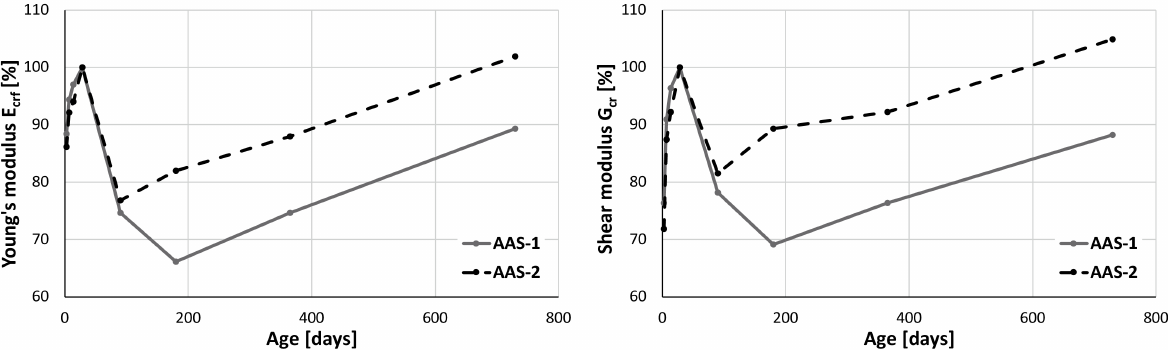
, the 28-day value represents cr